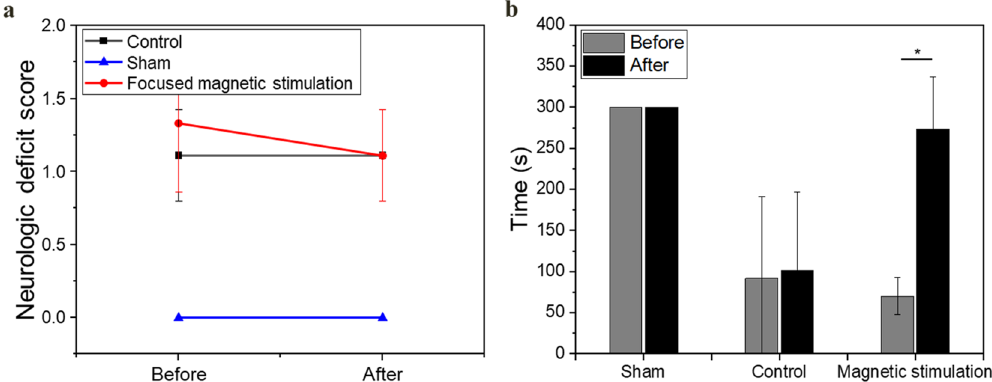
Figure 6. Behavioral assessment analysis and NDS for each group. ( a ) No deficit in the sham group (n = 9) was observed. The NDS value of the control group (n = 6) was maintained at 1 point. The NDS in the magnetic stimulation group (n = 9) was recovered after stimulation. ( b ) No decline or recovery of motor function was observed in the normal model of the sham group without stroke. In the control group, a stroke-induced decline in function was identified and did not recover over time. The magnetic stimulation group showed significant motor function recovery after stimulation (p <